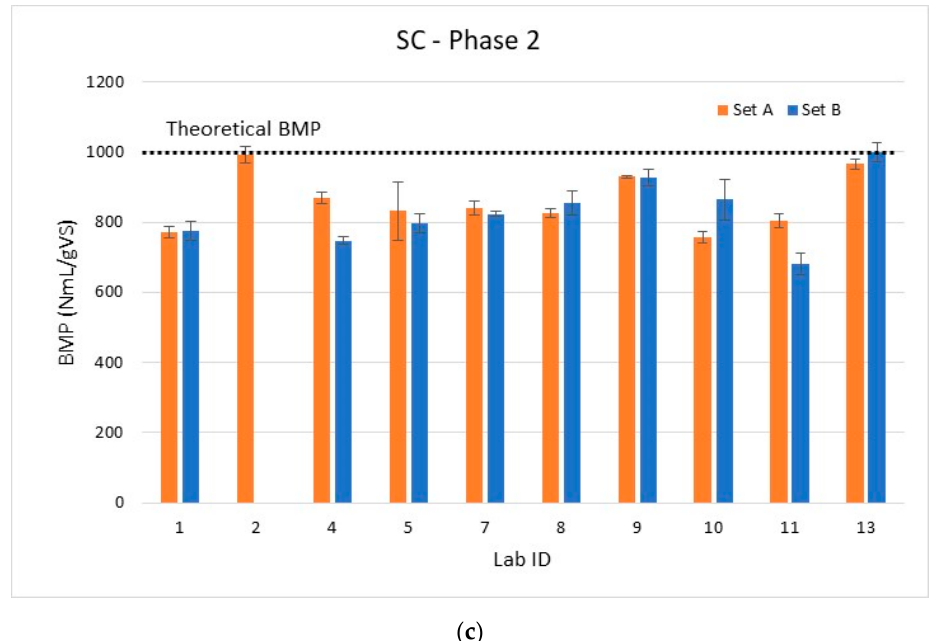
Figure 7. Summary of BMP values measured for the results of the second phase—harmonized protocol showing intra-laboratory repeatability and intra-laboratory reproducibility: ( a ) SA’; ( b ) SB; ( c ) SC.